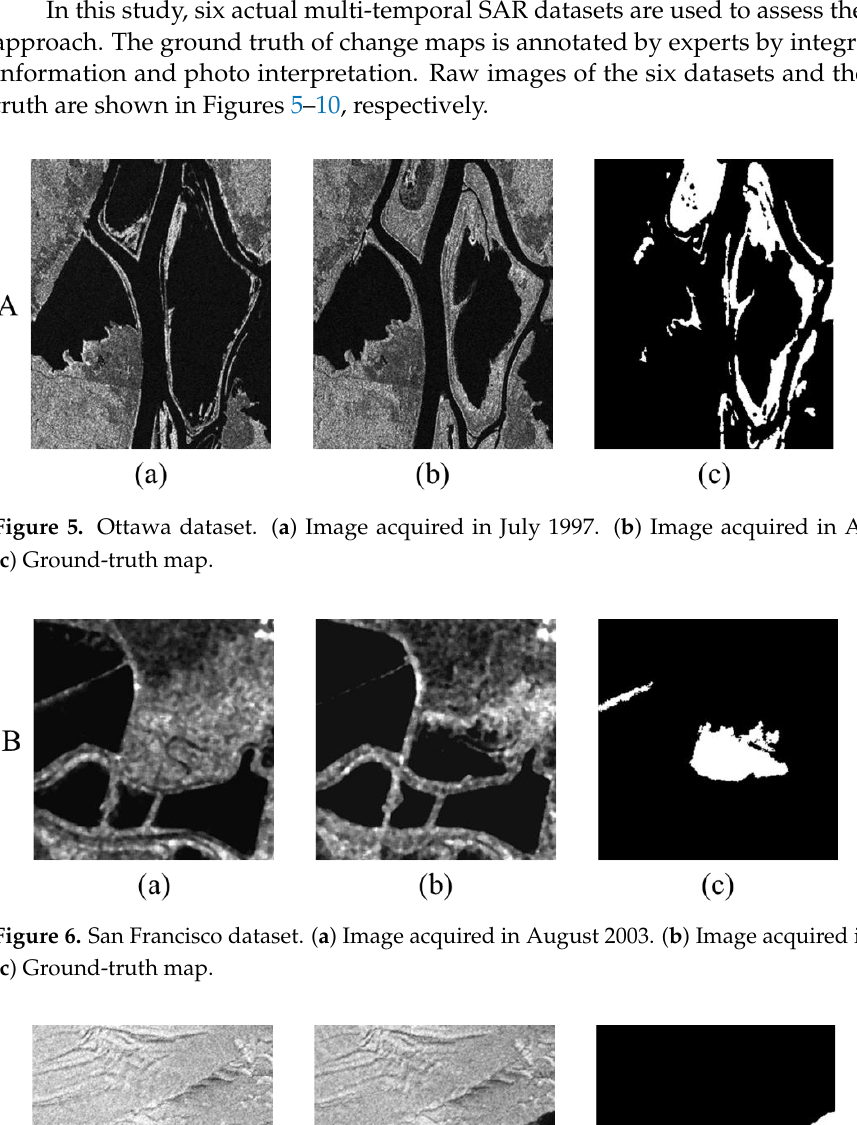
Figure 6. San Francisco dataset. ( a ) Image acquired in August 2003. ( b ) Image acquired in May 2004. ( c ) Ground-truth map.